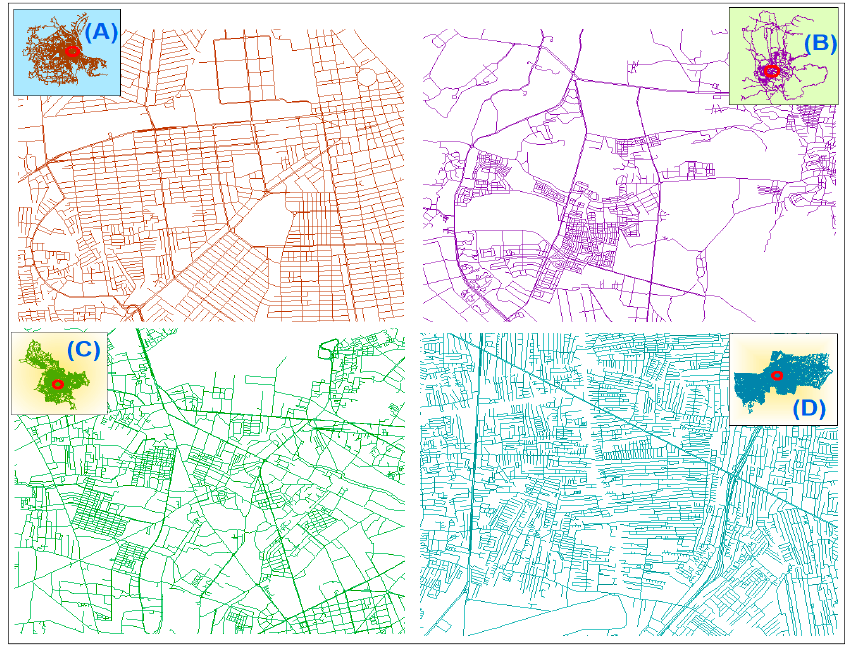
Figure 4. Comparisons of SN patterns in the city centre for four capitals in ASEAN—Phnom Penh ( A ), Naypyidaw ( B ), Ho Chi Minh City ( C ), and ( D )